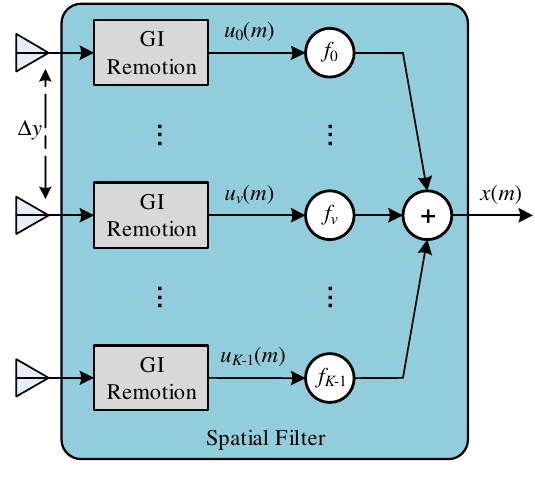
Figure 3. Antenna array with K equally-spaced